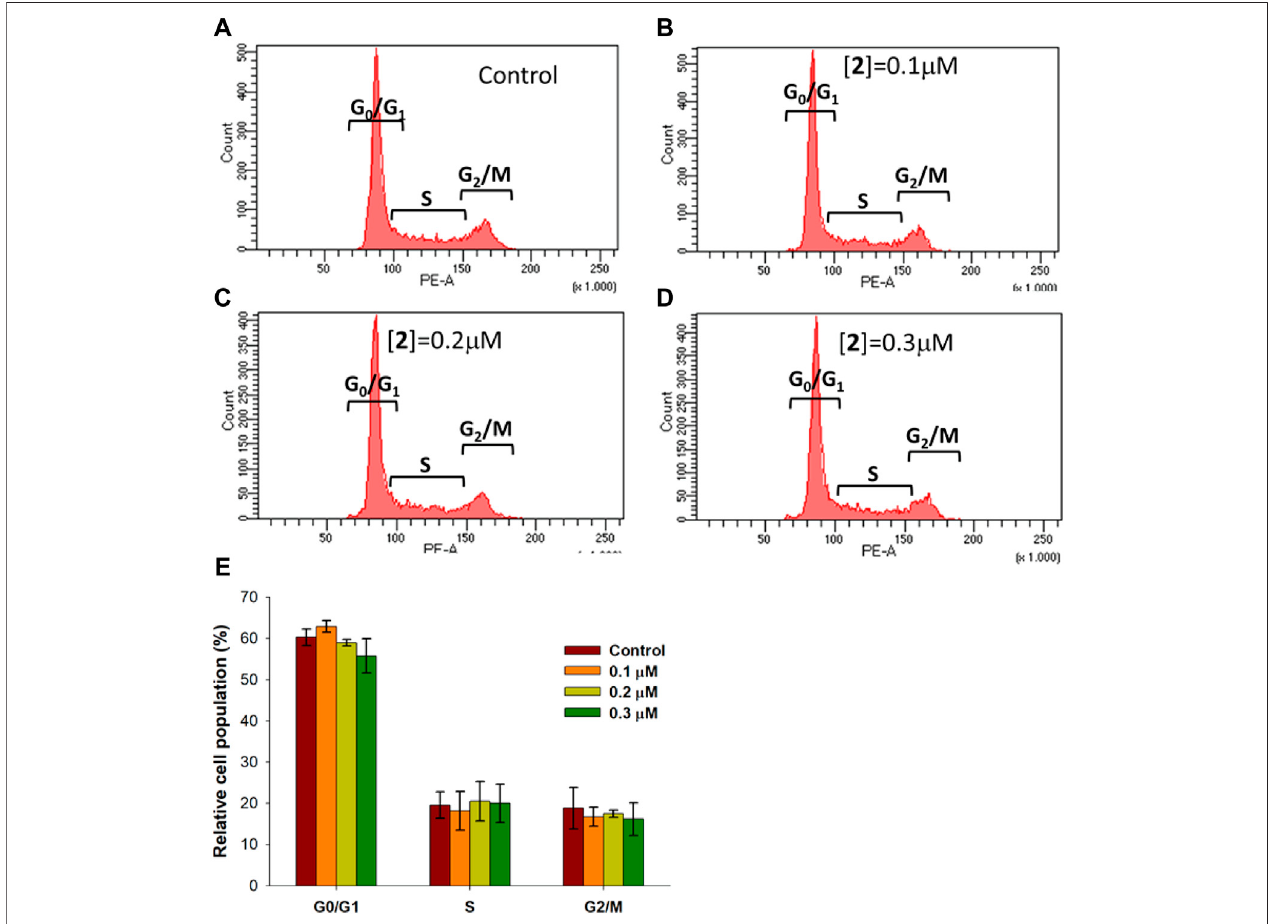
FIGURE3| CellcycledistributioninA2780cellstreatedwith 2 .A2780cellswereincubatedfor48 hwithcompound 2 atindicatedconcentrationsandanalyzedby fl ow cytometer after staining with PI. The dot plots show a representative experiment for untreated cells (control) (A) and cells treated with 2 at 0.1, 0.2, and 0.3 μ M concentrations ( B – D , respectively). Bar chart (E) represents the percentage of cells in each cell phase. Data are expressed as the mean ± SD from fi ve independent experiments. No signi fi cant difference was found between the control sample ( p > 0.05) and compound 2 at different concentrations for all cell cycle phases.